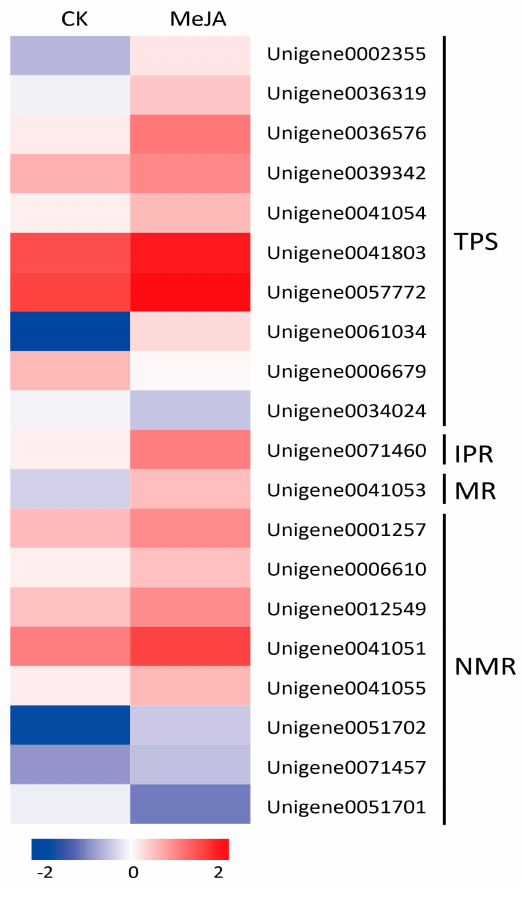
Figure 6. Heat maps of the DEGs in the monoterpenoid biosynthesis pathway. TPS, Terpene synthase; IPR, ( − )-Isopiperitenone reductase; MR, ( − )-Menthol dehydrogenase; NMR, (+)-Neomenthol